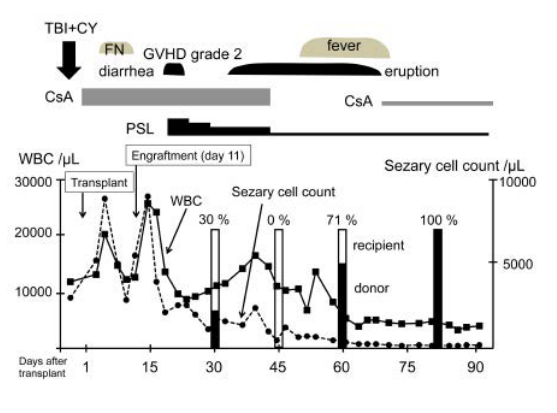
Figure 1. Clinical course. After tapering prednisolone and discon- tinuing cyclosporine, Sezary cells gradually decreased. Bars indi- cate the result of chimerism analyses of T-cell fraction. The black bar indicated the percentage of donor type. The white bar indi- cated the percentage of recipient type. After reducing the dose of immunosuppressants, the percentage of donor chimera in T-cell fraction increased. TBI, total body irradiation; CY, cyclophos- phamide; FN, febrile neutropenia; GVHD, graft-versus-host dis- ease; CsA, cyclosporine; PSL, prednisolone; WBC, white blood cell.